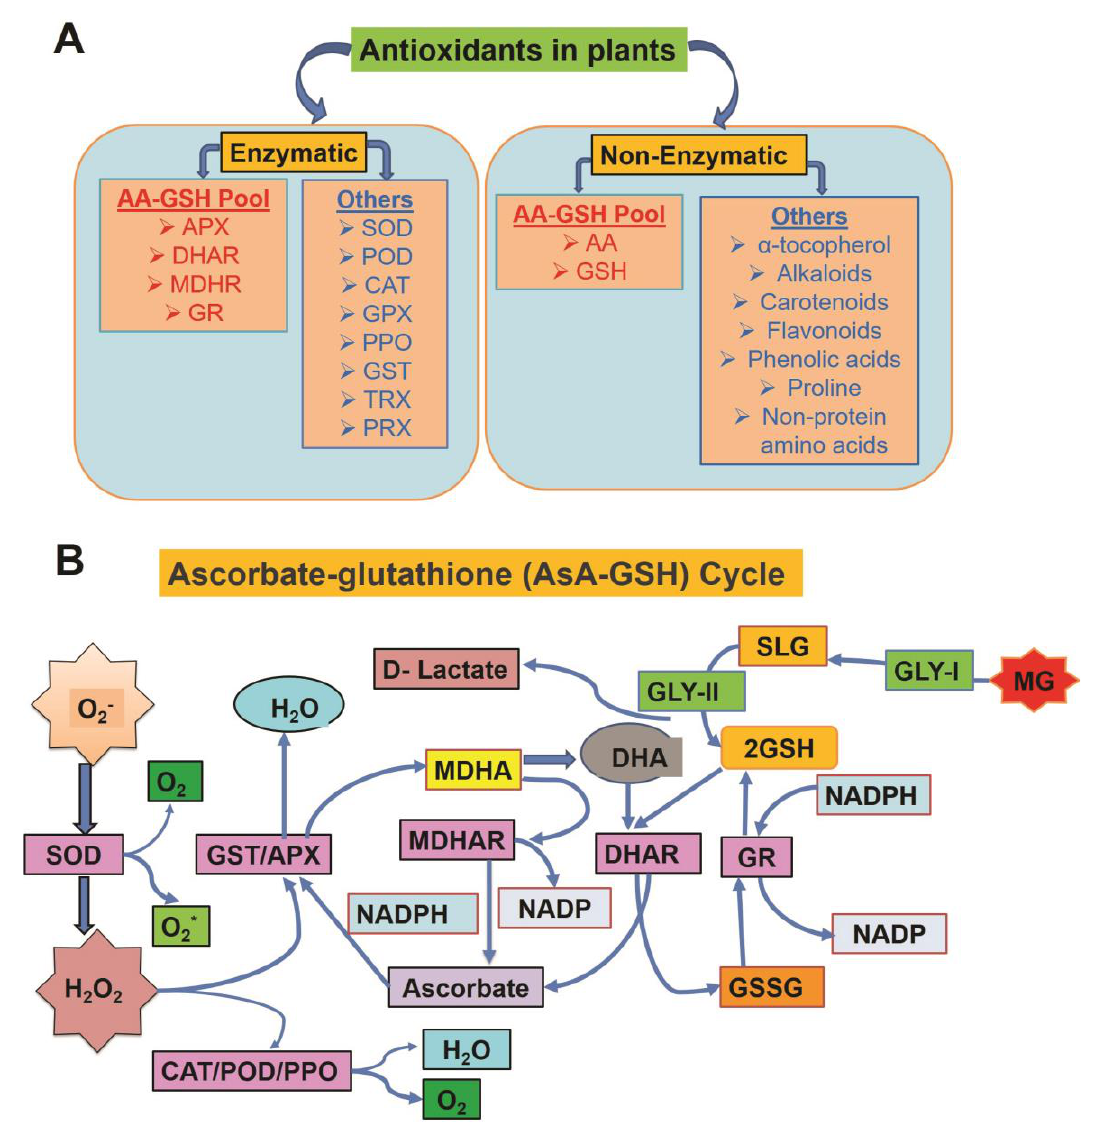
Figure 3. Antioxidant defense machinery in plants: ( A ) different types of antioxidants and ( B ) intricate regulatory mechanisms of enzymatic and non-enzymatic antioxidants. TRX, thioredoxin; SOD, superoxide dismutase; CAT, catalase; AA, ascorbic acid; AsA, ascorbate; APX, ascorbate peroxidase; DHAR, dehydroascorbate reductase; DHA, dehydroascorbate; GPX, glutathione peroxidase; H 2 O 2 , hydrogen peroxide; GSH, reduced glutathione; GR, glutathione reductase; GSSG, oxidized glutathione; MDHAR, monodehydroascorbate reductase; MDHA, monodehydroascorbate; GST, glutathione S-transferase; NADPH, nicotinamide adenine dinucleotide phosphate; DHA, dehydroascorbate; AsA, ascorbate; AA, ascorbic acid; AsA-GSH, ascorbate-glutathione; GLA-I, glyoxalase-I; GLA-II, glyoxalase-II; PPO, polyphenol oxidase; POD, peroxidases; PRX, peroxiredoxins; O 2 − • , superoxide anion; 1 O 2 , singlet oxygen; HO•, hydroxyl radical.